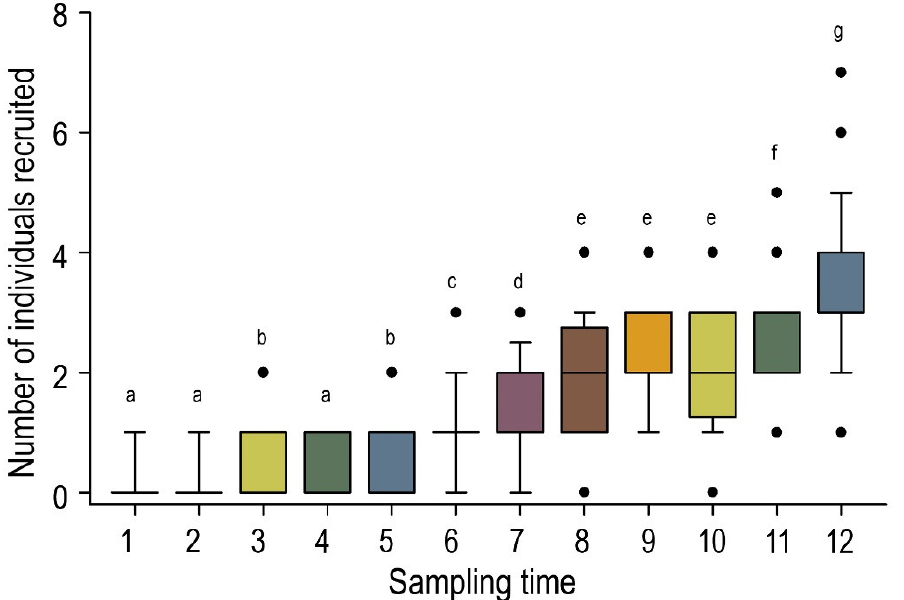
Figure 5. Boxplots of Trapezia crab’s recruitment on Pocillopora fragments. A decrease or absence of Trapezia suggests migration between colonies. Letters indicate significant differences between groups.